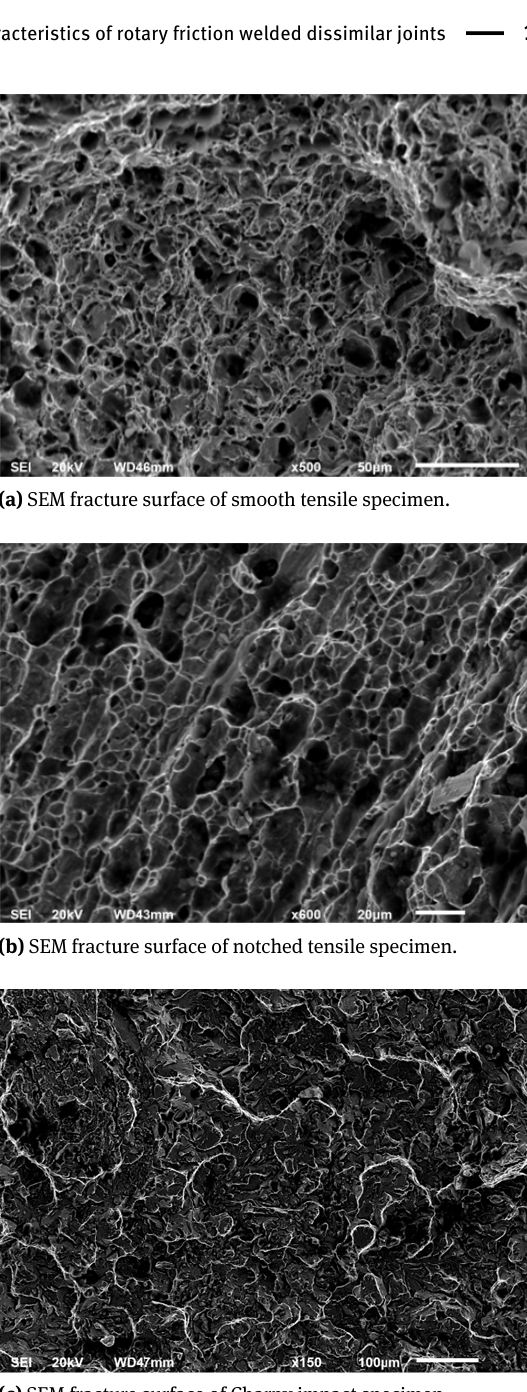
Figure 10: SEM fracture surface